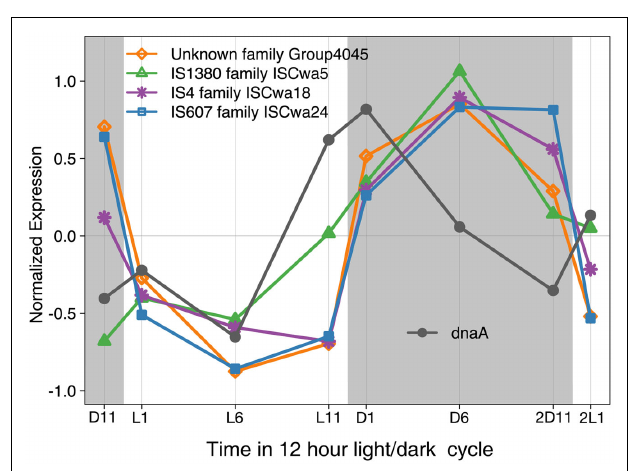
export are marked with green arrowheads. Descriptions of the numbered genes are listed below. See Table 2 for annotated functions and COG similarities of the 25 contiguous,WH0003-specific ORFs.(1) CWATWH0003_3507: “O-antigen translocase,” similar to wzx , (2) CWATWH0003_3515: “polysaccharide biosynthesis protein CapD,” (3) CWATWH0003_3516: “polysaccharide export protein,” similar to wza , and (4) CWATWH0003_3517: “uncharacterized protein involved in exopolysaccharide biosynthesis,” similar to wzc .